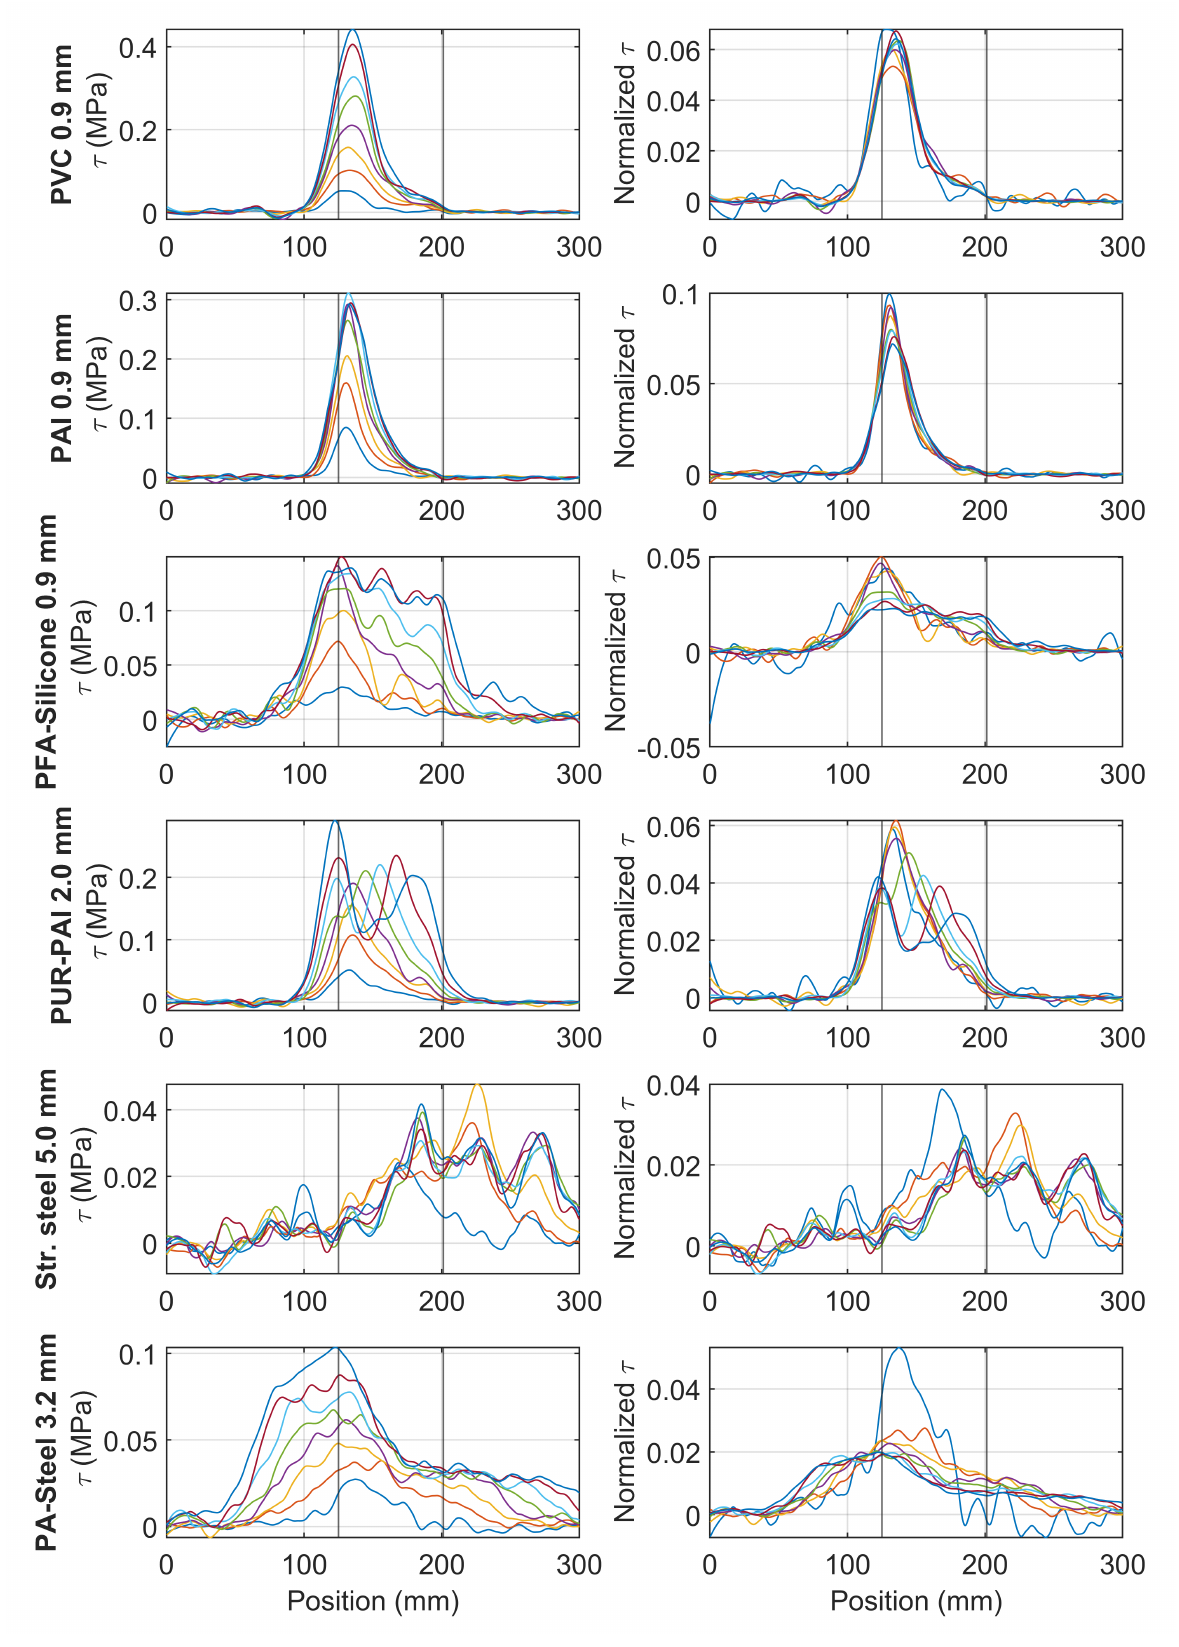
Figure 22. Shear stress distribution along the fiber optic core with increasing displacement demand (different color lines represent strain distributions under increasing displacement